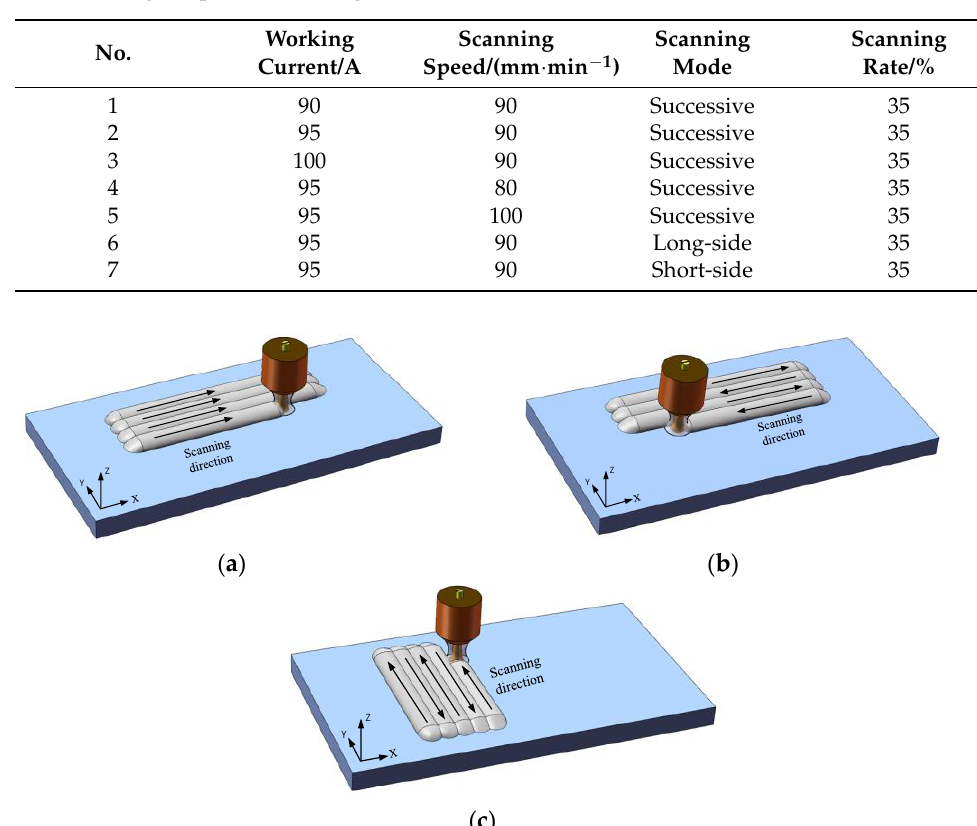
Figure 4. Different scanning modes: ( a ) Successive scanning; ( b ) Long-edge scanning; ( c ) Short-edge reciprocating scanning. reciprocating